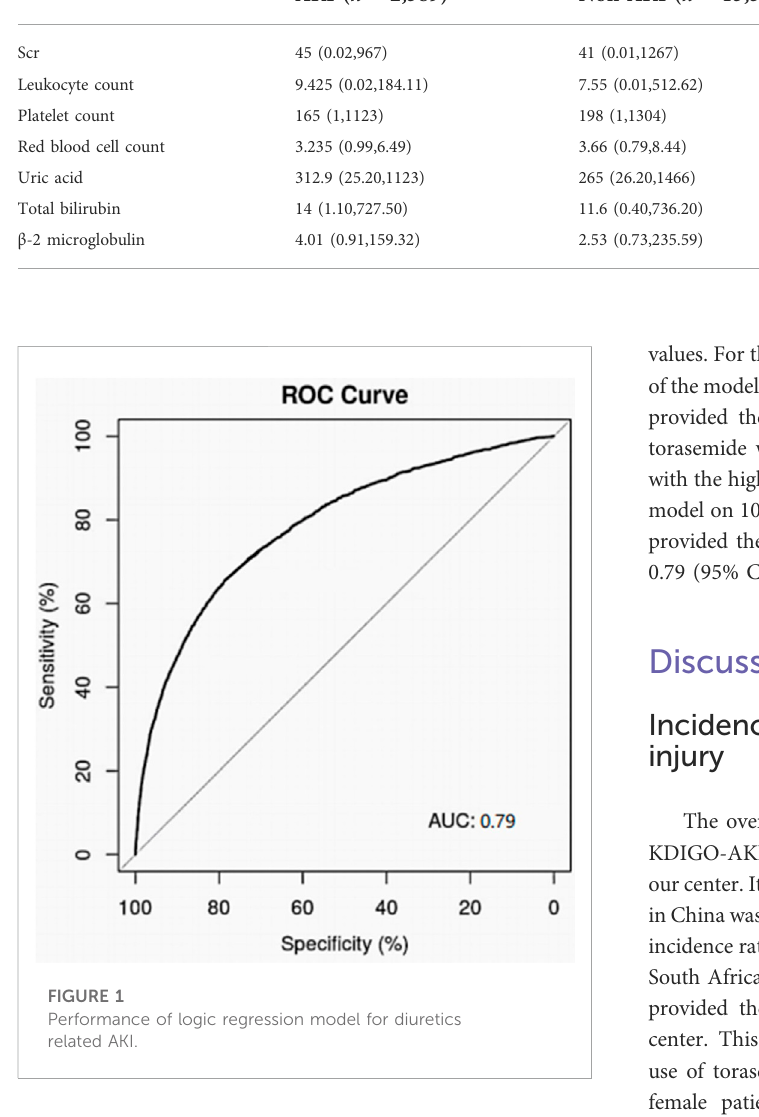
Table 5. The indicators used were the most recent values of test results obtained prior to the use of the study drug. As shown in the table, several important indicators were signi fi cantly different between the two groups, including serum creatinine (Scr), leukocyte count, platelet count, red blood cell count, uric acid, total bilirubin, and β -2 microglobulin.